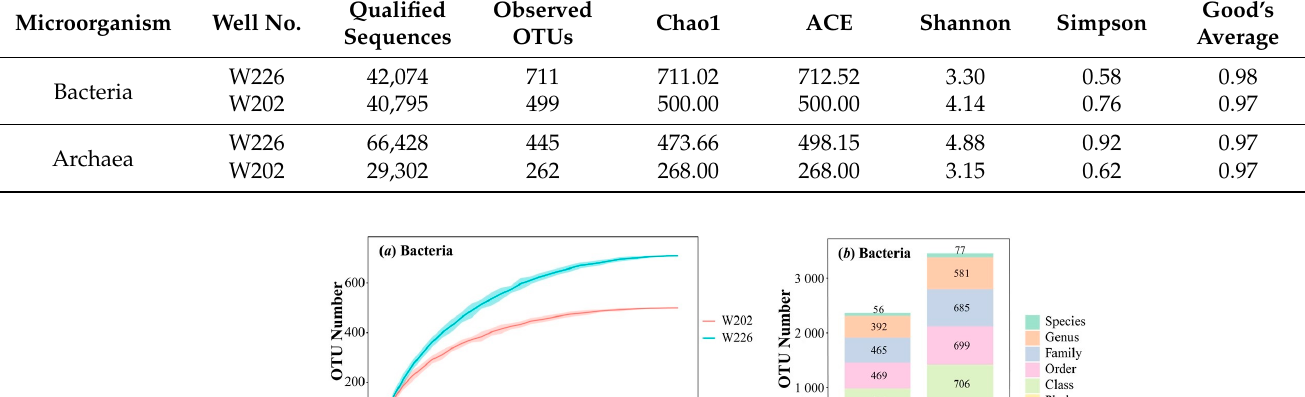
Table 3. The observed OTUs and alpha diversity indices of the samples. Microorganism